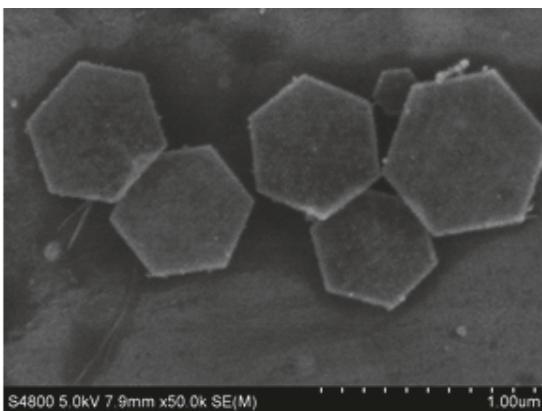
Figure 1: SEM image of Bi 2 Te 3 nanosheets.